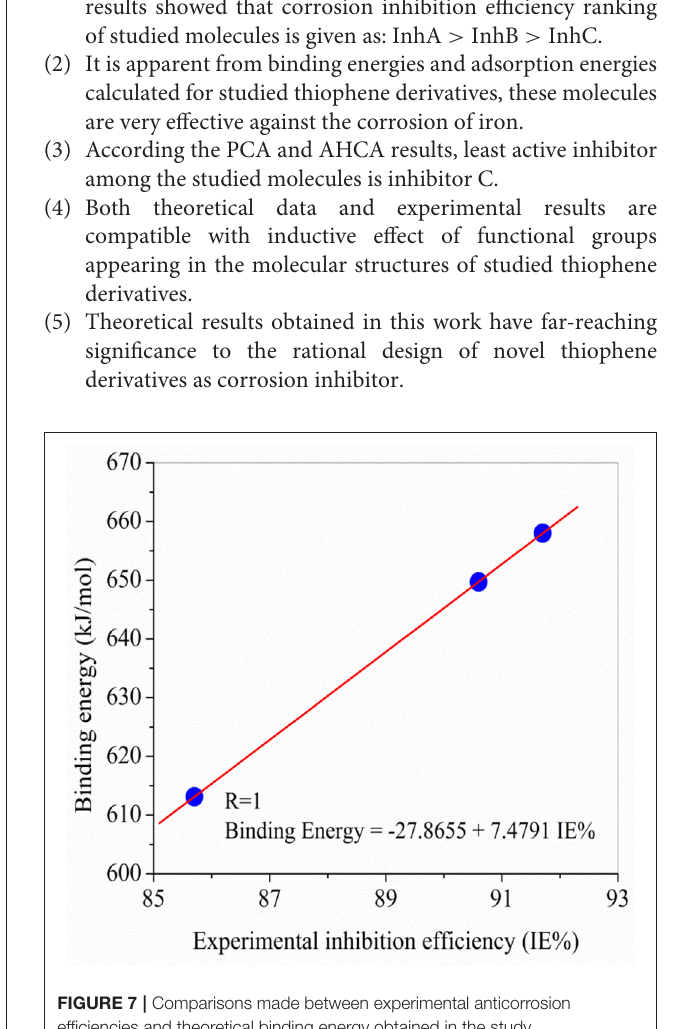
Frontiers in Chemistry |